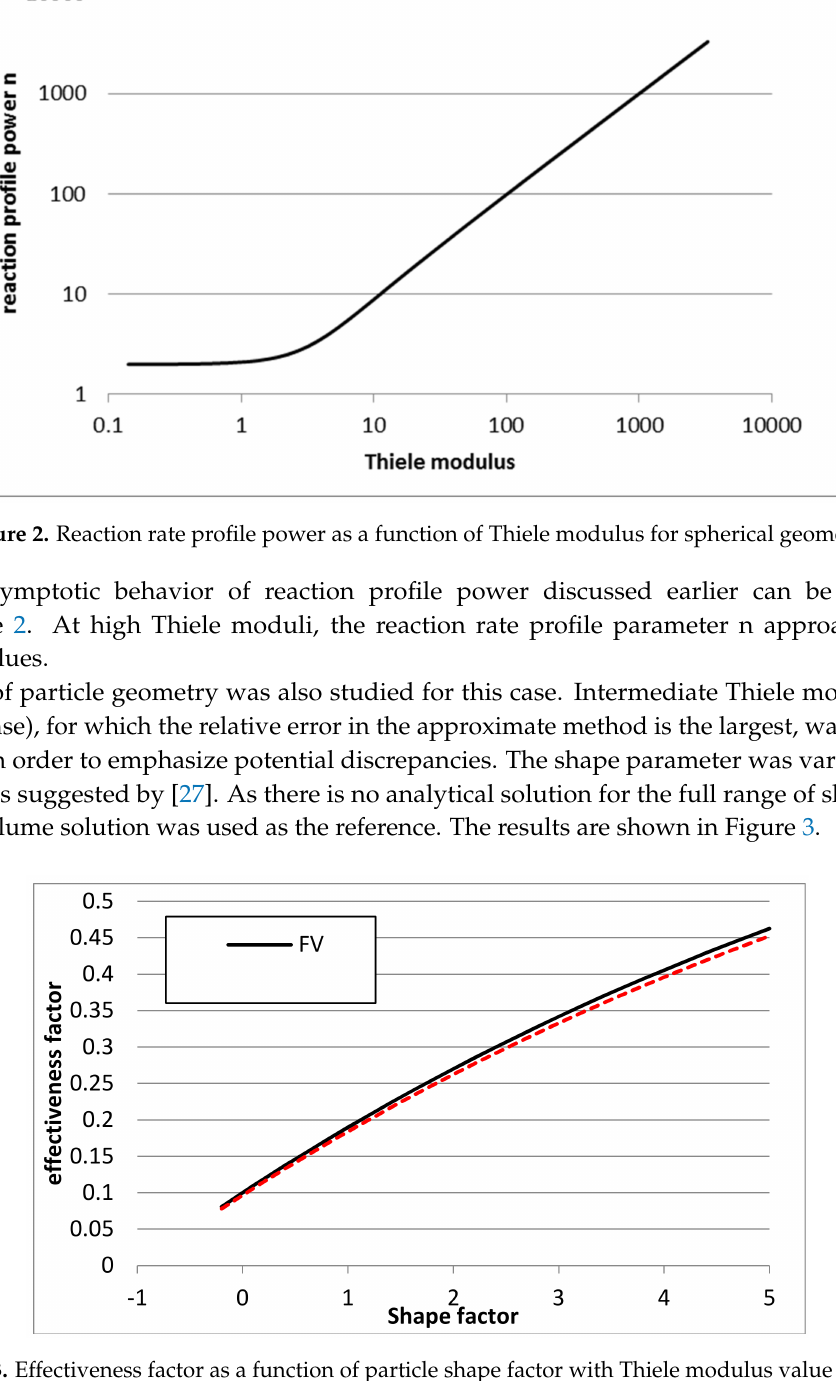
Figure 3. Effectiveness factor as a function of particle shape factor with Thiele modulus value of 10 for the finite volume (FV) and the present approximate